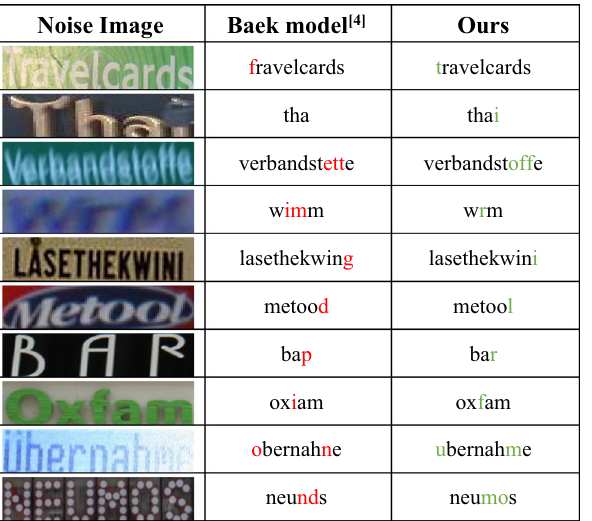
Fig. 1 Recognition effect comparison of proposed NRSTRNet and best model presented in [4]. The first column shows examples of noisy text images, including image blurring, image ghosting, and background interference. The second column shows the recogni- tion results obtained by the model proposed in [4]. The third column shows the prediction results of the model proposed in this paper. The red and green characters indicate wrong and correct results, respec-